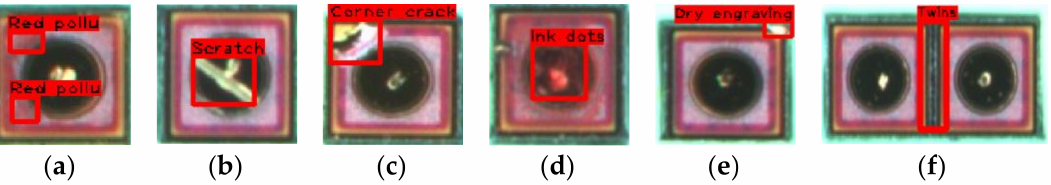
dots; ( e ) dry engraving; ( f ) twins.